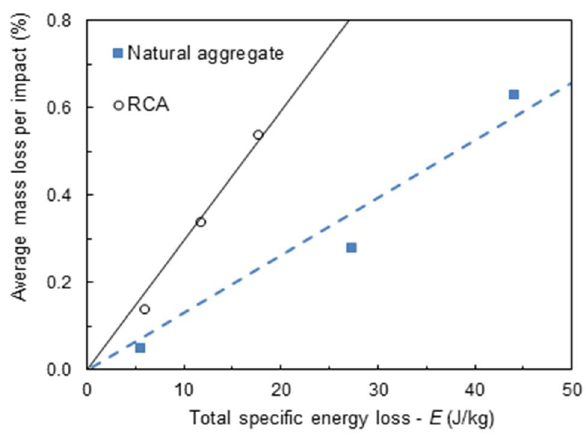
Figure 4. Comparison between measurements of average mass loss per impact and Equation (4) with the fitted value of ξ for the natural aggregate (19–22 mm) from the earlier work by Neves and Tavares [31] and to the recycled aggregate (RCA) from the present work (10–14 mm) ( ξ = 0.0063 s 2 m − 3 for natural aggregate and 0.0250 s 2 m − 3 for